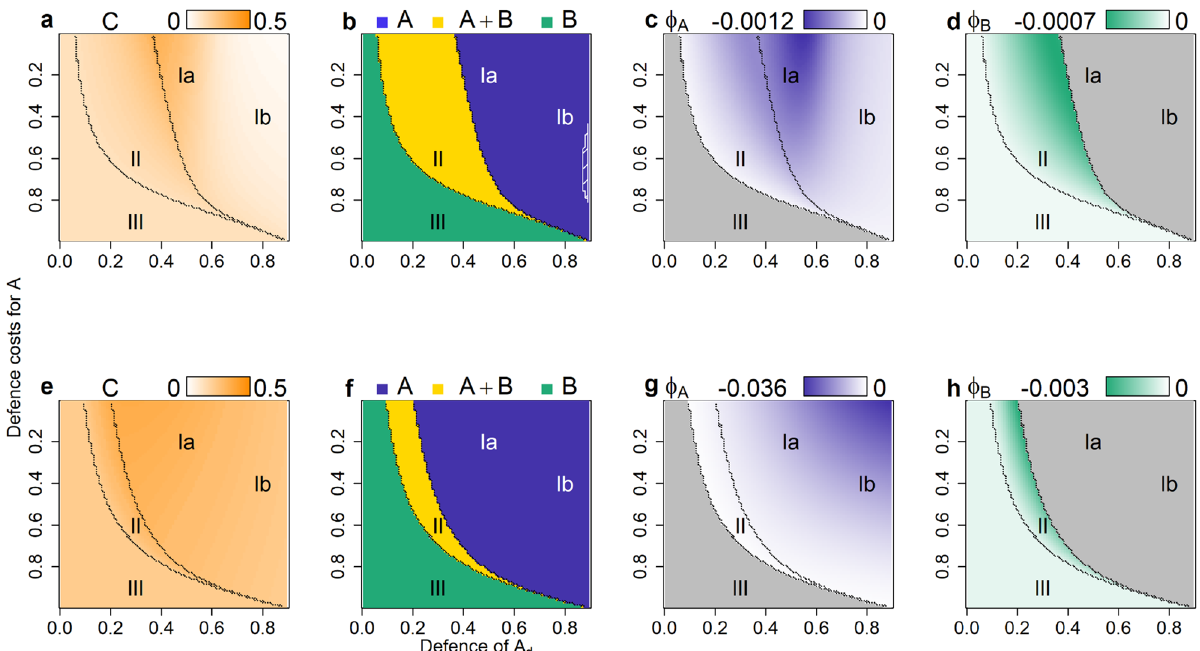
Figure 5. Coexistence and maladaptive switching for scenario angle 0.01 ( a – d ) and angle 1 ( e – h ). Consumer biomass ( a , e ), the autotroph coexistence patterns ( b , f ), and the autotrophs’ maladaptive switching Φ ( c , d , g , h ) (higher biomasses or more intensive maladaptive switching are shown by darker colours). Lines separate the regions I–III of different autotroph coexistence. The y-axis is reversed to follow the pattern of increasing fitness. Shaded areas in ( b ) depict antiphase cycles. Grey areas in ( c , d , g , h ) depict areas where the species was extinct. Note that ( c , d , g , h ) have each a different colour